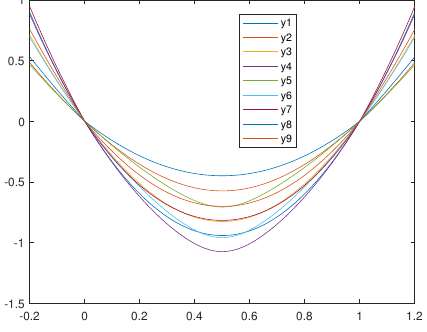
( x ) for i , j = fi , gi